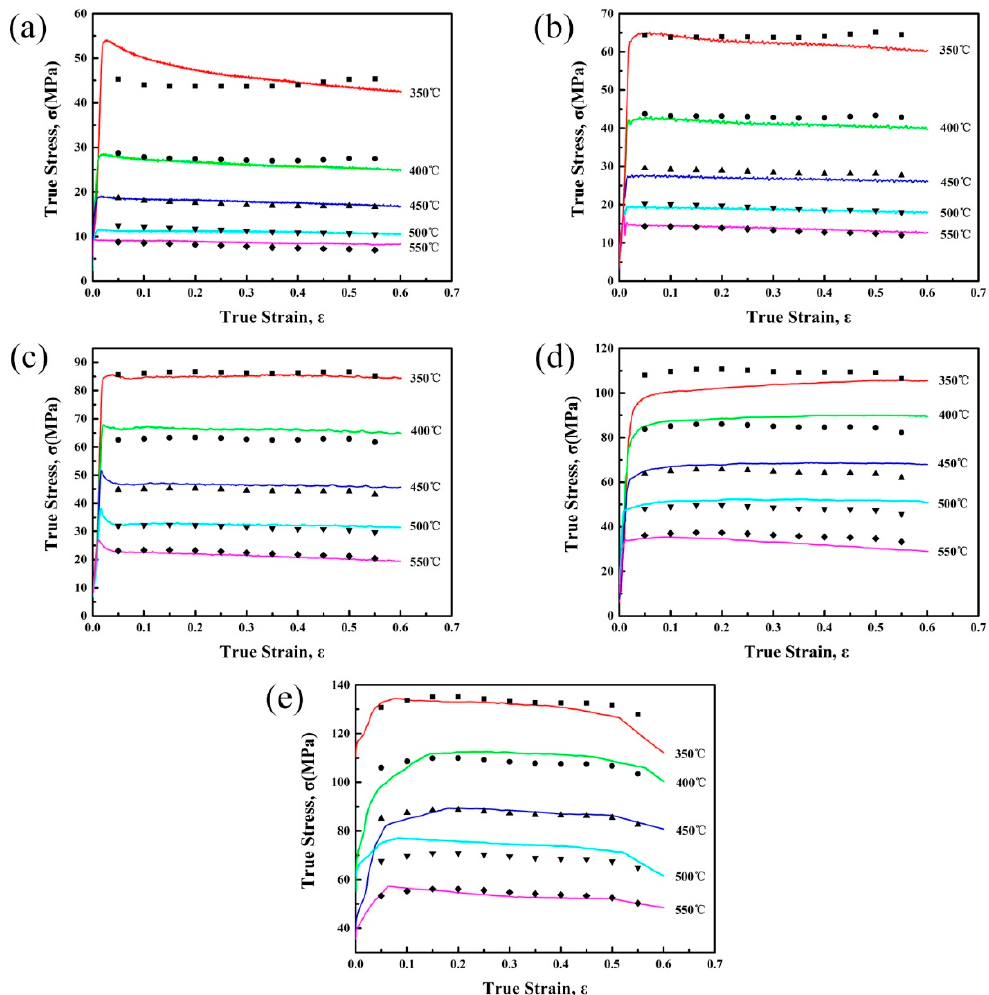
Figure 5. Comparison between flow stress calculated from constitutive equation with strain compensation (symbols) and experimental data (curves). ( a ) 0.001 s − 1 ; ( b ) 0.01 s − 1 ; ( c ) 0.1 s − 1 ; ( d ), 1 s − 1 and ( e ) 10 s − 1 .